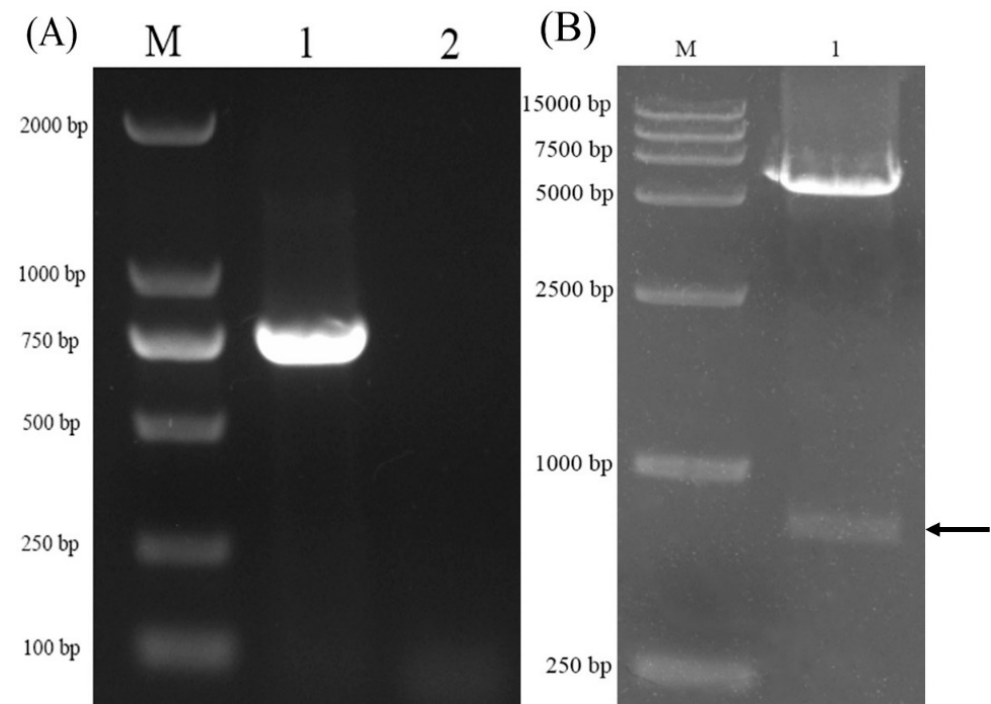
Figure 1. Electrophoretogram of the target gene. ( A ) PCR identification of recombinant Escherichia coli ; M: DL2000; lane 1: E. coli (pET-32a-VP8*); lane 2: E. coli Rosetta (DE3). ( B ) PCR identification of pET-32a-VP8*; M: DL15000; lane 1: the products of pET-32a-VP8* by double-restriction-enzyme digestion.